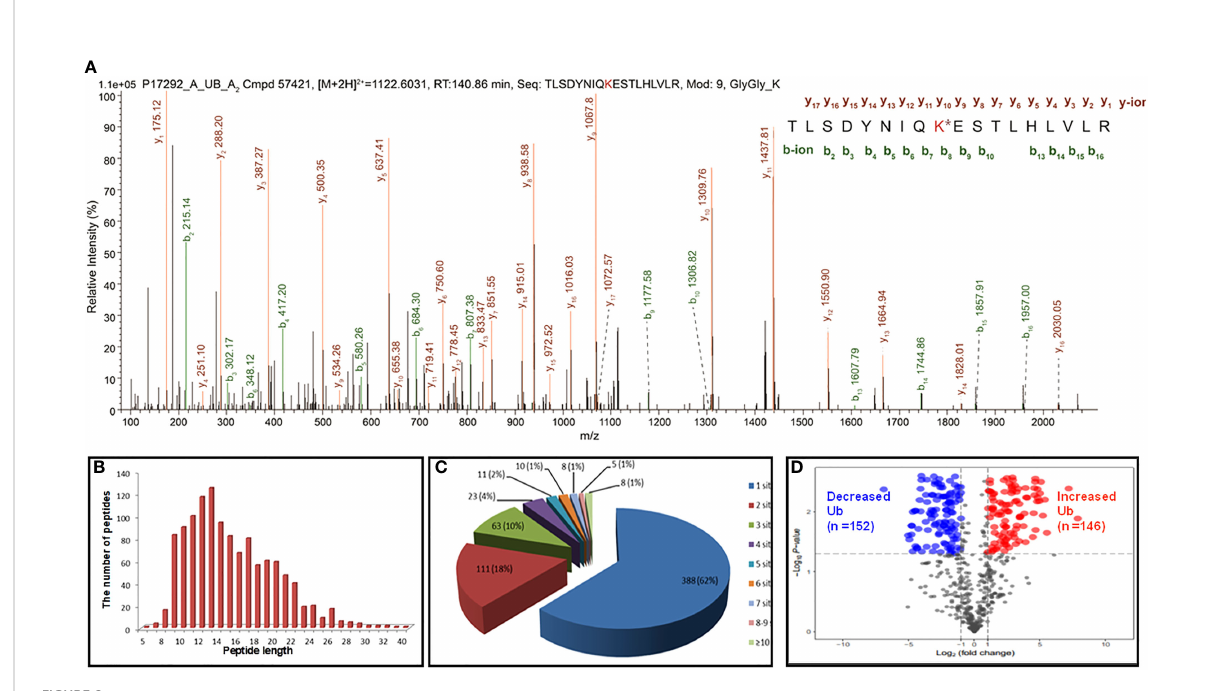
FIGURE 2 Representative MS/MS spectra and holistic characteristics of ubiquitination sites in LSCC. (A) The identi fi ed ubiquitinated peptide 55 TLSDYNIQK*ESTLHLVLR 72 from 40S ribosomal protein S27a (RPS27A, P62987). K* = ubiquitinated lysine residue. (B) The length distribution of identi fi ed ubiquitinated peptides. (C) Pie-chart demonstrating the number of ubiquitination sites per protein. (D) Volcano plot demonstrated the changes in the degree of ubiquitination at a special lysine site among 642 ubiquitination sites (T+/N+) according to the fold change and p value between the LSCC and control groups. X axis: the log of the fold change between the two conditions (log base 2). Y axis: the negative log of the p value (log base 10). Red dot indicates that the degree of ubiquitination of the site is signi fi cantly increased (Ratio T/N>2.0; p<0.05) and blue indicates signi fi cantly decreased (Ratio T/N < 0.5;